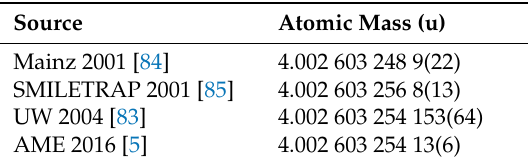
Table 7. Atomic mass values for 4